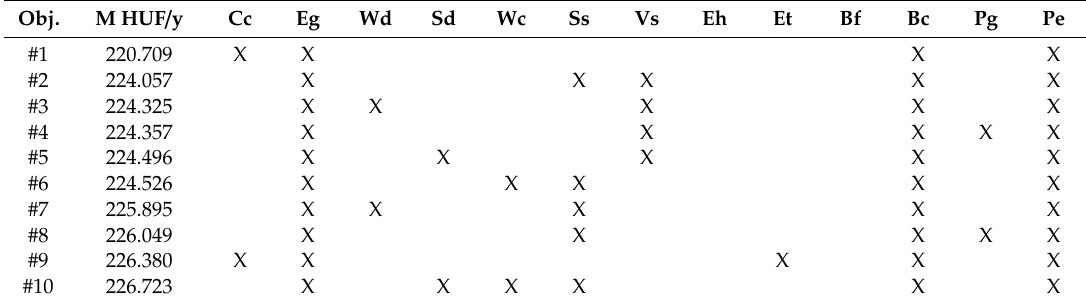
Table 8. The 10 best solution structures for the single period P-Graph model, minimizing yearly operation costs. The objective values as well as the used technologies and biomass types are depicted *.